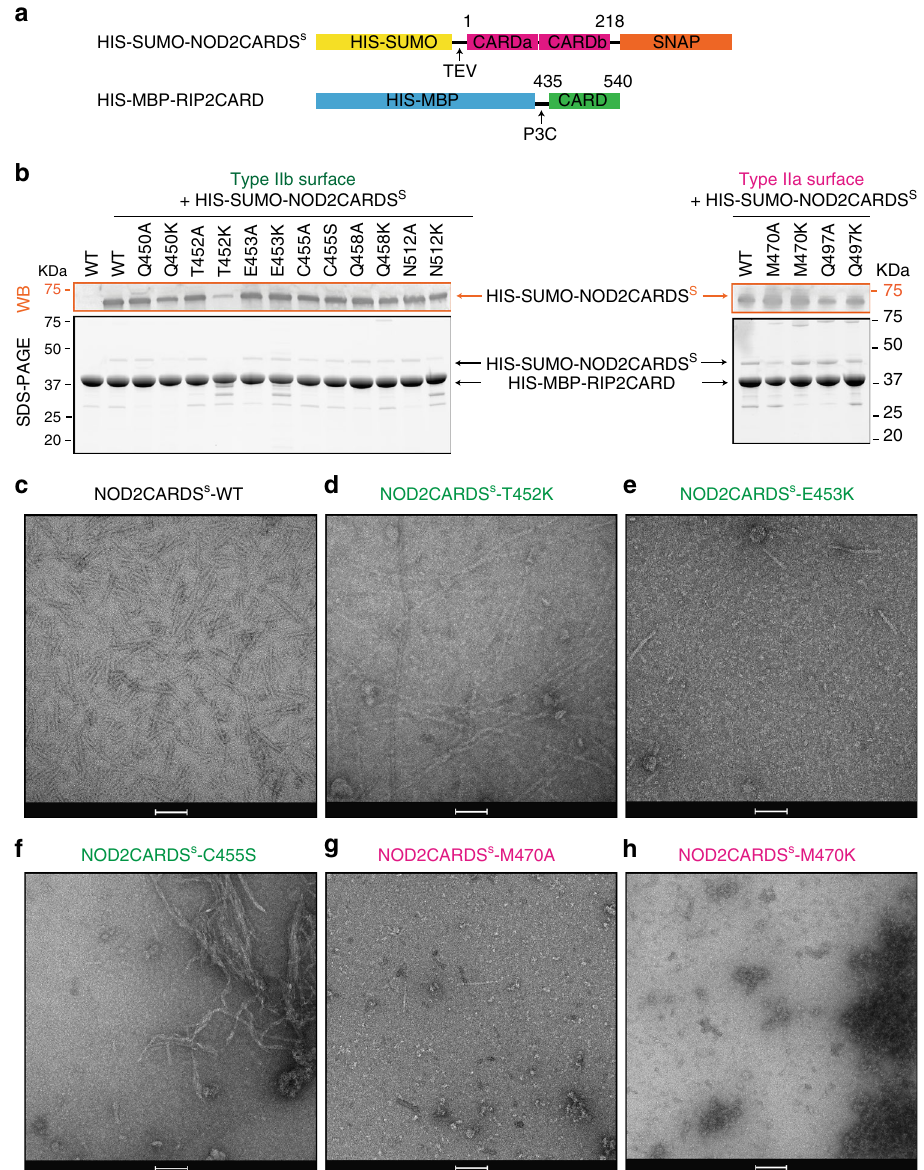
Fig. 8 Effect of type II surface mutations on RIP2CARD polymerization. a Domain organization of the NOD2CARDS and RIP2CARD constructs used for testing the behaviour of RIP2CARD mutants. b Western blot (WB, top panel) and 12.5% SDS-PAGE (bottom panel) of NOD2CARDS s -RIP2CARD type II interface mutant co-puri fi cation at the amylose elution step (EAR). For clarity, only relevant lanes are labelled. Type IIa and IIb surfaces are coloured as in Fig. 7. c – h Example micrographs of ( c ) NOD2CARDS s -WT, ( d ) NOD2CARDS s -T452K, ( e ) NOD2CARDS s -E453K, ( f ) NOD2CARDS s -C455S, ( g ) NOD2CARDS s -M470A and ( h ) NOD2CARDS s -M470K, after tag cleavage. Scale bars are 100